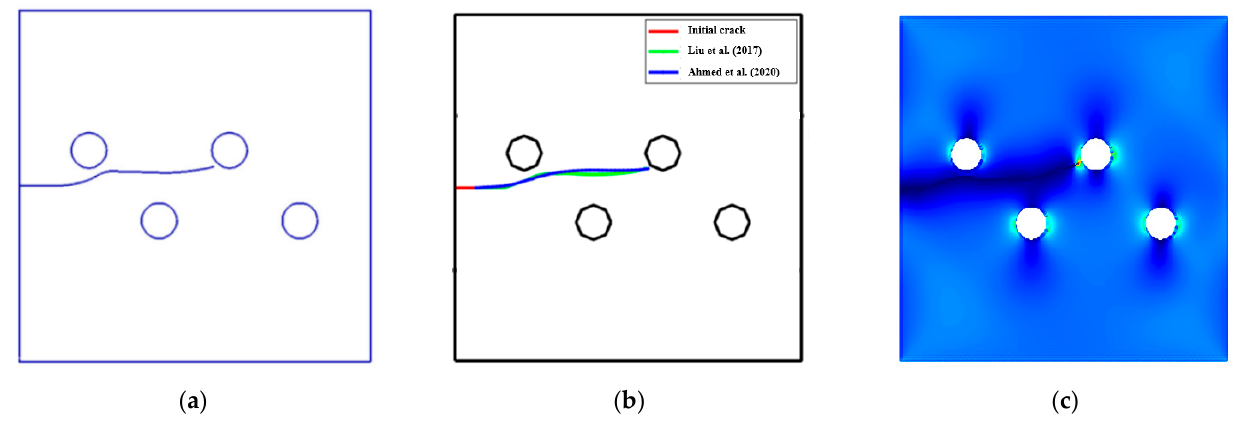
Figure 4. Crack growth trajectory: ( a ) Liu et al. FMM BEM [38] , ( b ) Ahmed et al. [39] , and ( c ) Wira- gunarsa et al. [40] .